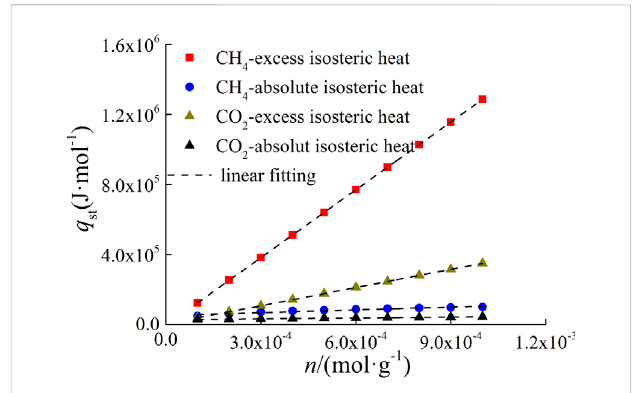
FIGURE 9 The isosteric heat of adsoptionunder different types of adsorption